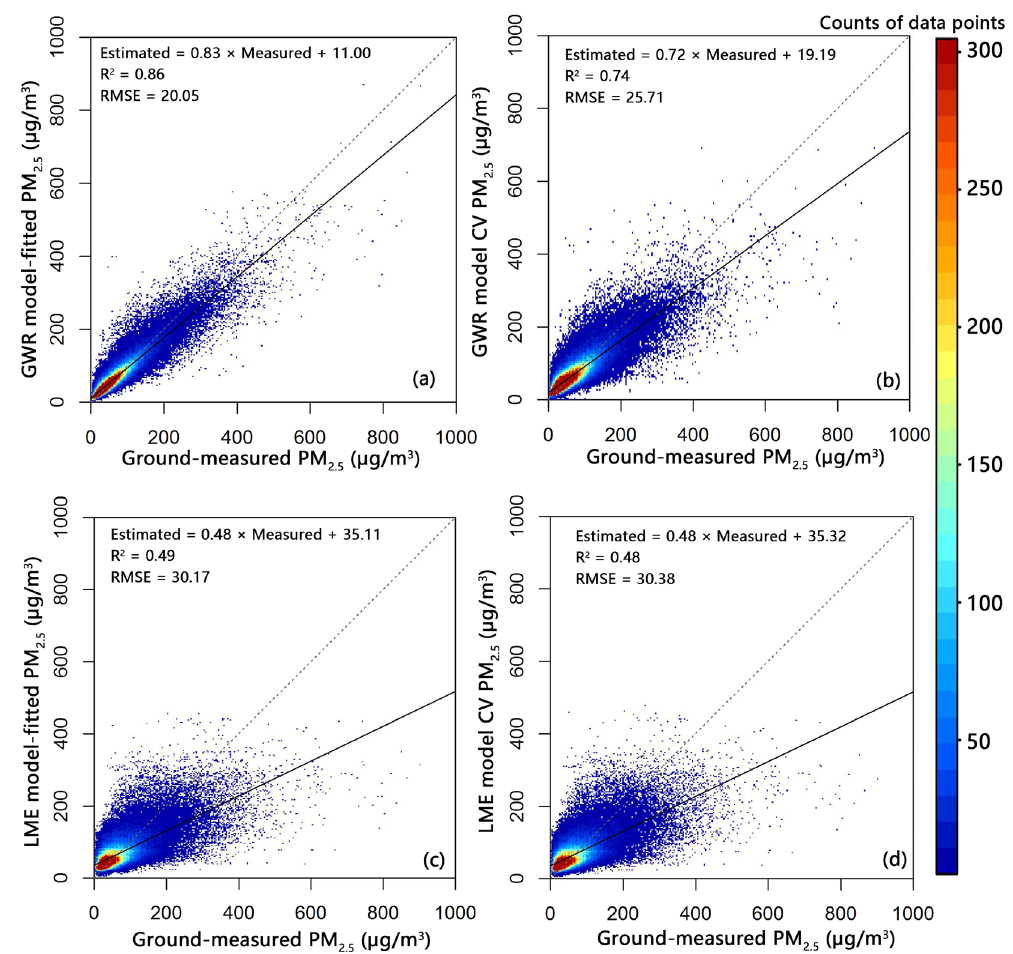
Figure 4. Model fitting and cross validation using GWR and the LME model (N = 162,089). RMSE: root mean squared error of the predictions ( µ g/m 3 ). For reference, the 1:1 line is shown as a dashed line. Panels (a) and (b) show the model fitting and cross-validation results of the GWR model, whereas panels (c) and (d) show the model fitting and cross-validation results of the LME model,